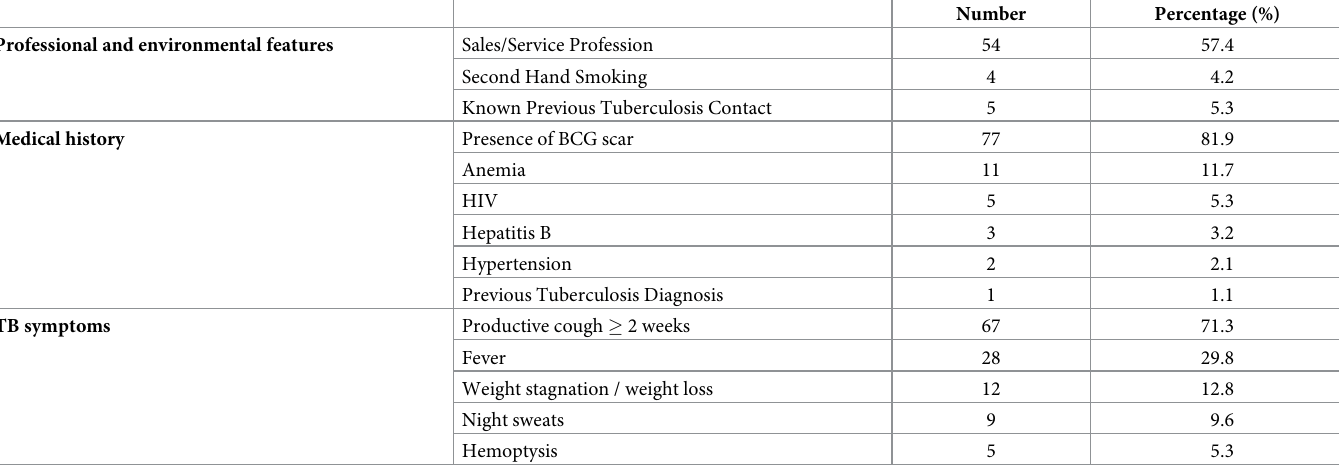
Table 3. Profession, smoking status, medical history, and tuberculosis symptoms present among pregnant women with cough of at least two weeks during antenatal care visits (N =